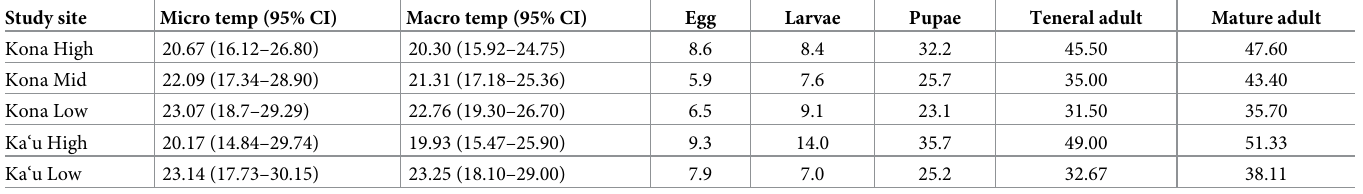
Table 3. Summary of mean daily temperatures at the micro (branch) and macro (farm) scales and the 95% Confidence Interval (CI), as well as days to first appear- ance of each life stage averaged across all 10 branches at each study site. Study site